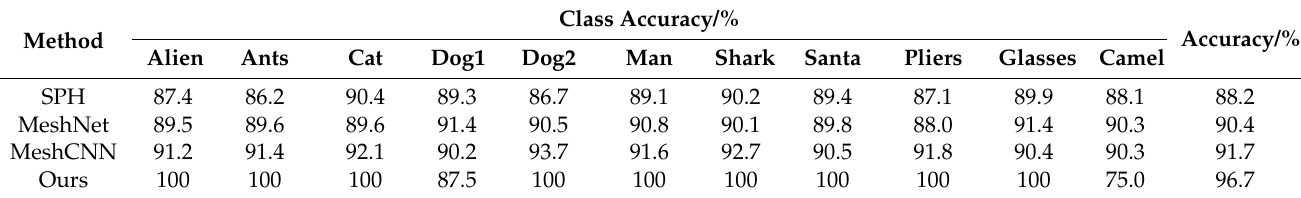
Table 1. Classification accuracy of different methods on SHREC15.